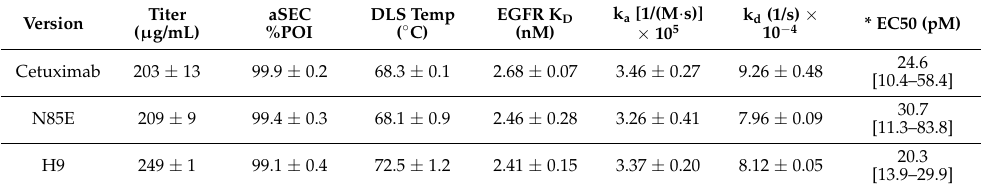
Figure 3. Binding kinetics of cetuximab-derived scFv-monoFc proteins ( A ) and mAbs ( B ), as determined by biolayer interferometry using anti-human Fc (AHC) sensors and soluble recombinant extracellular domain of human EGFR. Data are representative of two independent experiments. K D values are shown in Tables 2 and 3. N85E is aglycosylated cetuximab, and H1 through H11 are humanized variants. Table 3. Biophysical properties of cetuximab-derived monoclonal